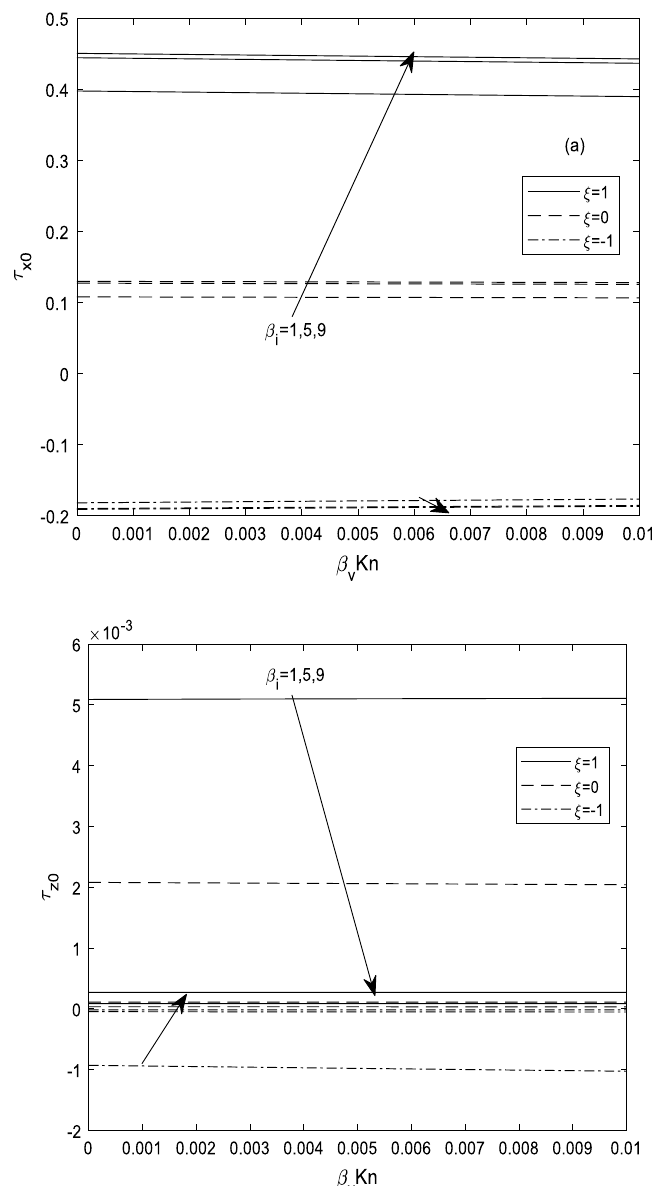
Fig. 12 a Ion-slip parameter ( β i ) on the main flow and induced skin friction profiles at y = 0 , for β v Kn = 0.05, M = 2,ln = 1.667, M = 2.0, β h = 0.10 and Pr = 0.71 . b Ion-slip parameter ( β i ) on the main flow and induced skin friction profiles at y = 0 , for β v Kn = 0.05, M = 2,ln = 1.667, M = 2.0, β h = 0.10 and Pr =